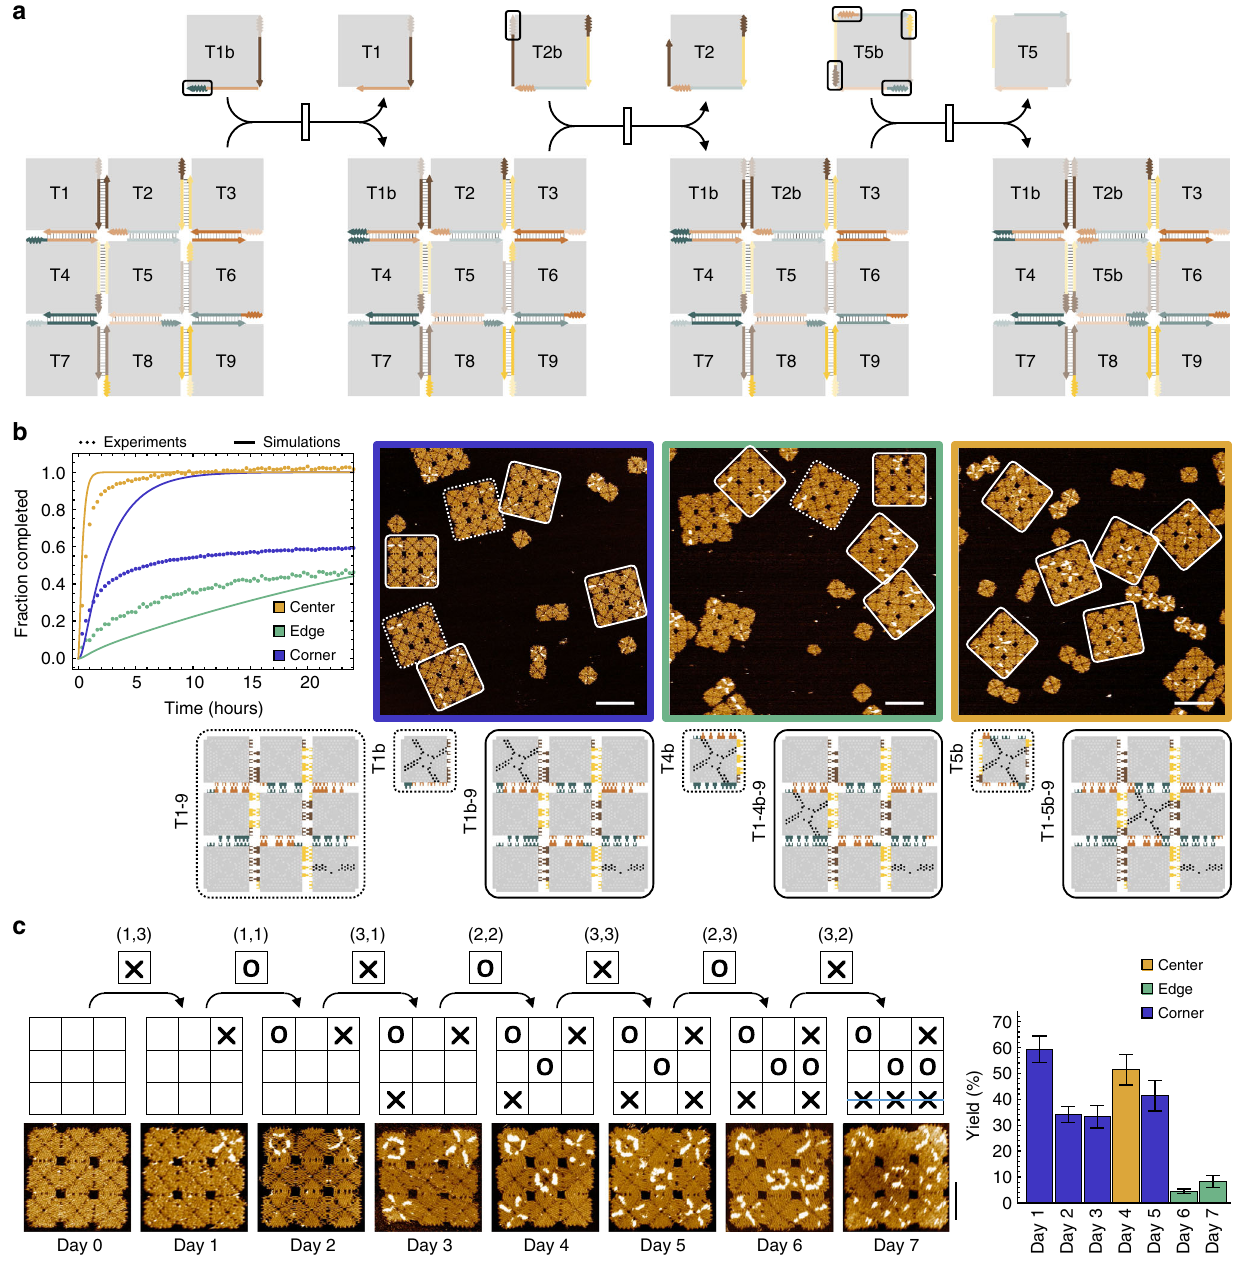
Fig. 4 Generality of DNA tile displacement. a Three types of tile displacement reactions, shown in a cascade, in 3 by 3 arrays. 12 toehold and 12 branch migration domains with unique sets of edge staples are in distinct colors. Toeholds used to initiate each reaction are highlighted in boxes. b Fluorescence kinetics experiments, simulations, and AFM images of three example reactions, one of each type, performed separately. All three reactions have the same array as a reactant at 4 nM and distinct invader tiles at 8 nM. In AFM images, dotted and solid boxes highlight reactants and products, respectively. Species names of multi-tile complexes are further abbreviated by replacing continuous tile numbers with a dash (e.g., T1-9 indicates T123456789). Scale bars are 200 nm. c Design diagram, AFM images, and yield estimation of a tic-tac-toe game. Two players each have 9 tiles labeled with X or O, each of which is designed to displace one speci fi c tile from the array. ( x , y ) indicates the position of the tile to be displaced is in row x and column y . Scale bar is 100 nm. Yield was estimated as the number of desired products (shown in the design diagram and representative AFM image for each day) divided by the total number of all 3 by 3 arrays in 10 by 10 μ m AFM images. The standard error was calculated as p number of arrays, treating the yield as a Bernoulli probability. n = 54, 82, 39, 37, 29, 22, and 12 for days 1 through 7. Error bars correspond to the